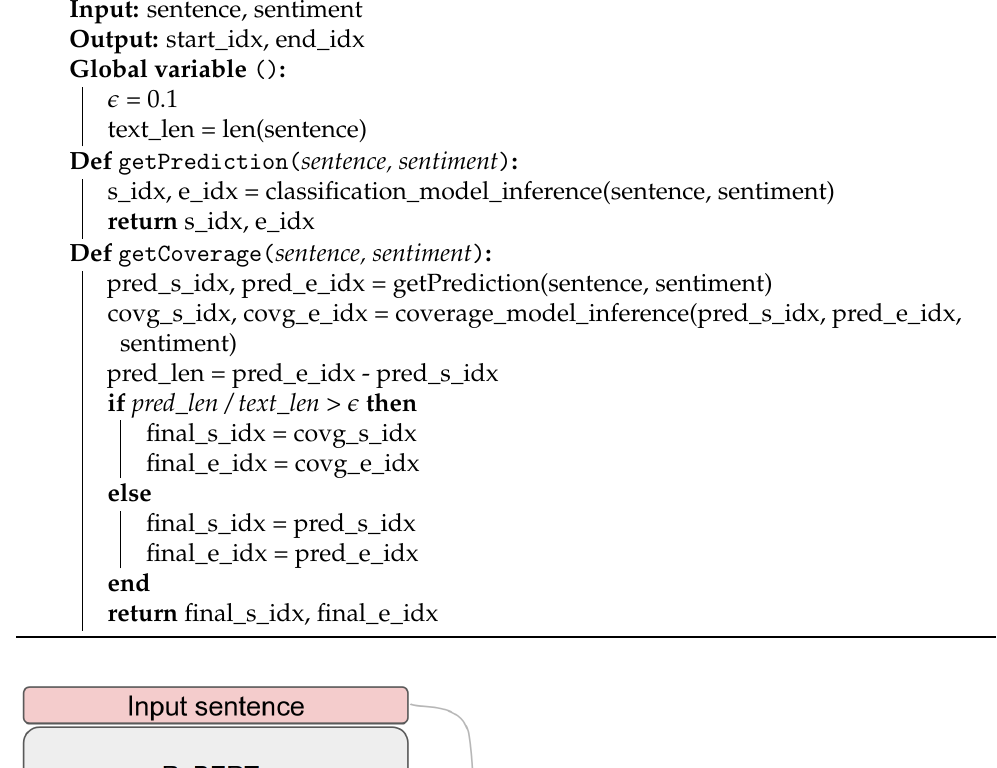
Algorithm 1: Coverage-based subsentence extraction algorithm.